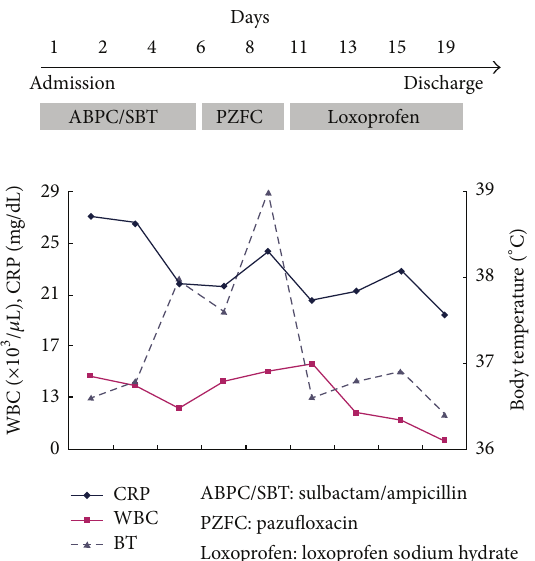
Figure 4: Clinical course after admission. Soon after admission, high-grade fever developed. Therefore, antibiotics administration was initiated (sulbactam/ampicillin at 3.0g/day for 6 days, and, subsequently, pazufloxacin at 1000 mg/day for 4 days); the elevated inflammatory marker levels and high-grade fever were not resolved. After administering a non-steroidal anti-inflammatory drug (lox- oprofen sodium hydrate at 180mg/day), temperature returned to normal. White blood cell counts and C-reactive protein levels remained